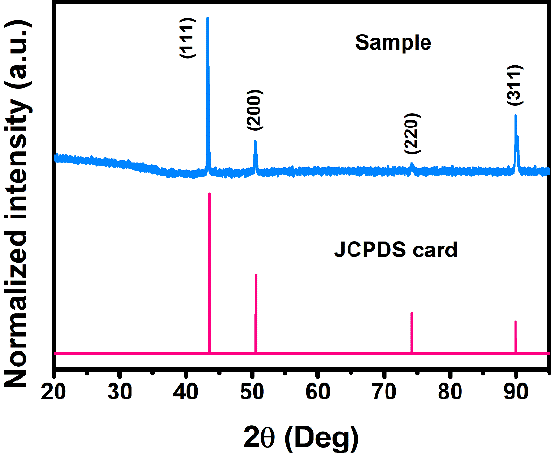
Figure 1. XRD results of the steel sample.